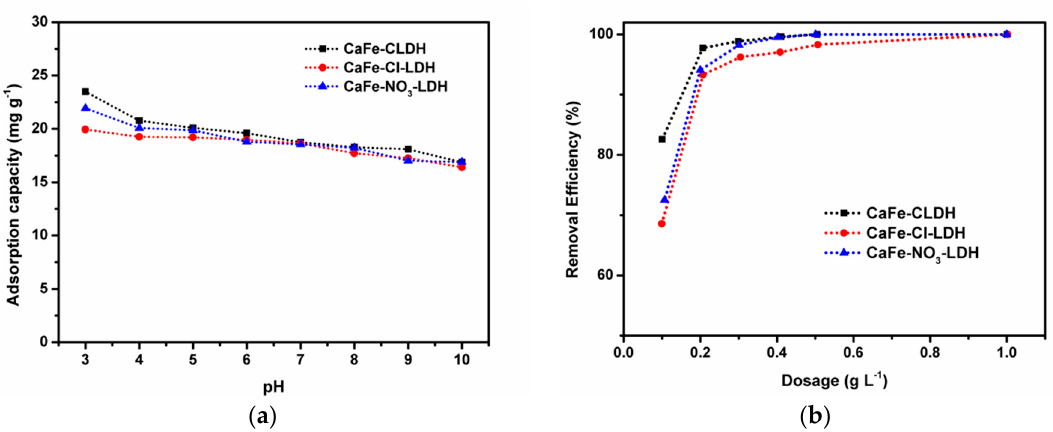
Figure 5. ( a ) Effect of pH on arsenic adsorption [Experimental condition: initial concentration of arsenate was 5 mg·L − 1 , materials dosage = 0.2 g·L − 1 ]. ( b ) Effect of dosage on arsenic adsorption (Experimental condition: initial concentration of arsenate was 5 mg·L − 1 , initial pH = 6.0).